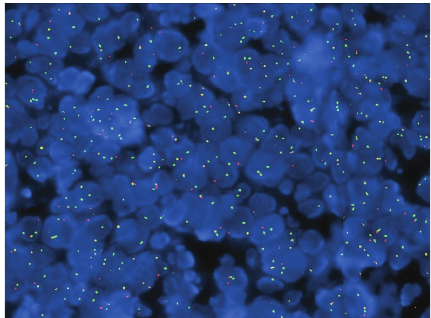
Figure 5: MYC Break Apart: complex and unusual rearrangement of MYC gene. Probe used: ZytoVision ZytoLight SPEC CMYC Dual Color Break Apart